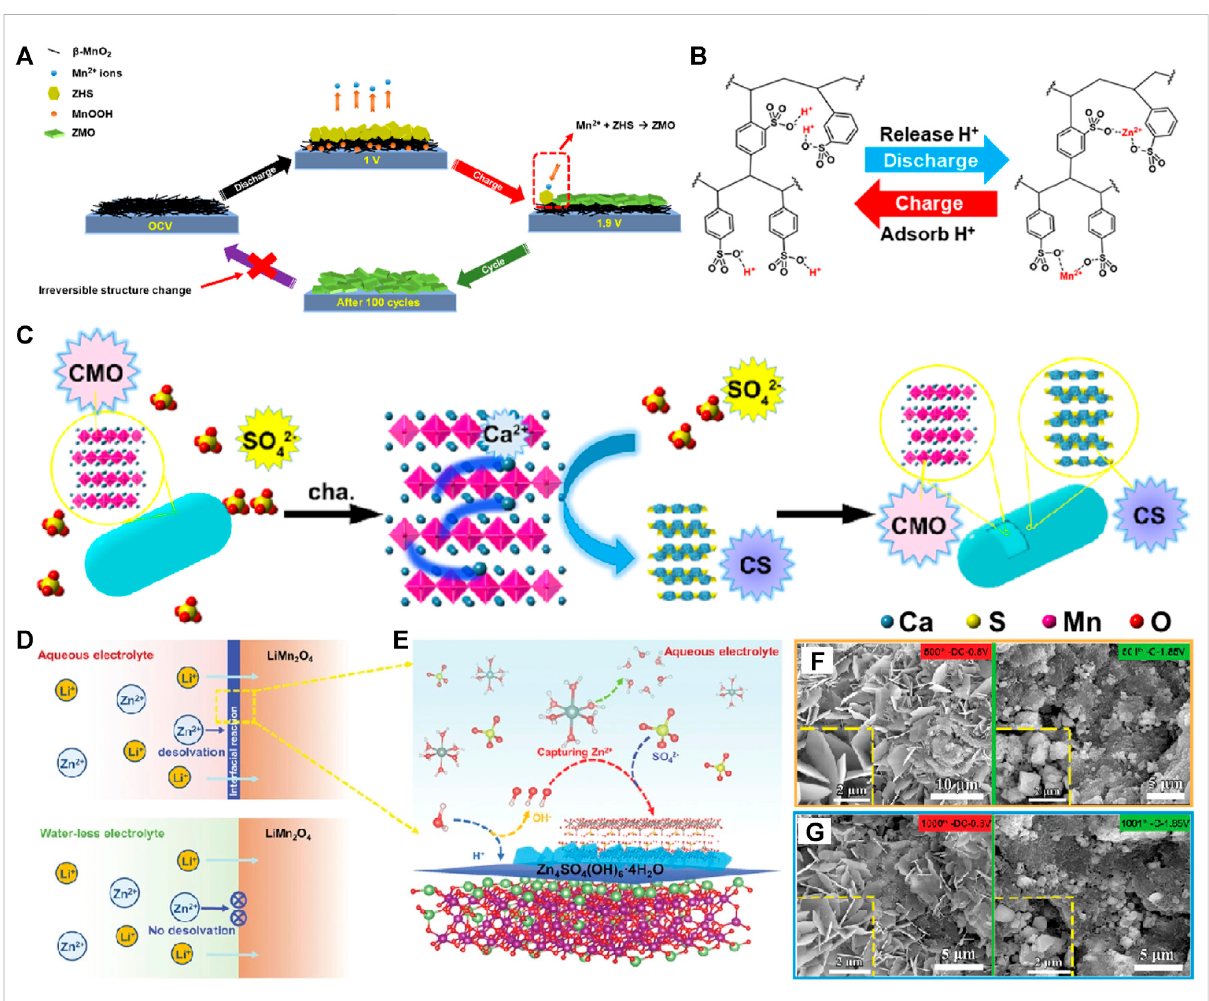
FIGURE 2 (A) Aschematicillustrationoftheirreversiblestructurechangeonthe β -MnO protons. (C) The formation mechanism of the unique structure of CaSO 4 · 2H 2 O (CS) SEI layer-coated Ca 2 MnO 4 (CMO). (D) Schematic illustration of cathode/electrolyte interface in aqueous and waterless electrolyte. (E) The working mechanism of the interfacial reaction of the LiMn 2 O-cathode in ZnSO 4 -based aqueous electrolyte. (F) The ex-situ SEM images at fully discharged/charged state after (G) the 500th cycle and (E) the 1000th